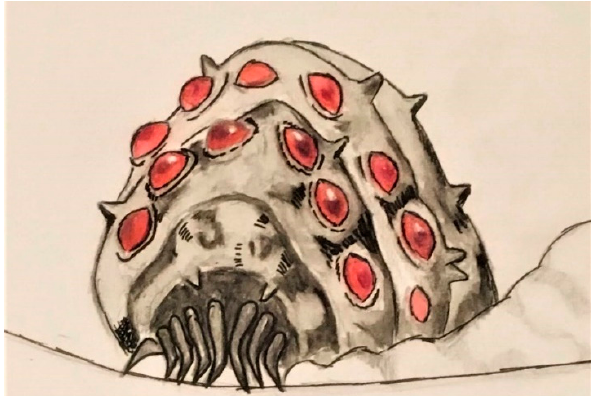
Figure 2. An Ohmu during their swarming behavior, as depicted in Nausicaä of the Valley of the Wind